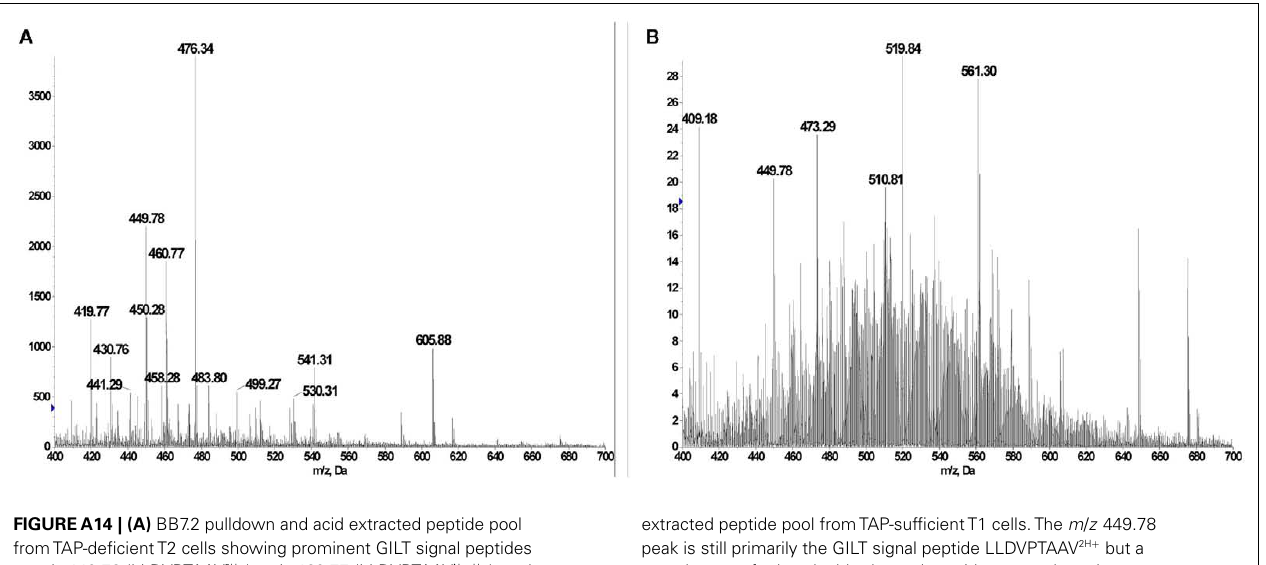
extracted peptide pool fromTAP-sufficientT1 cells.The m / z 449.78 peak is still primarily the GILT signal peptide LLDVPTAAV 2H + but a complex set of other doubly charged peptides cover the m / z range